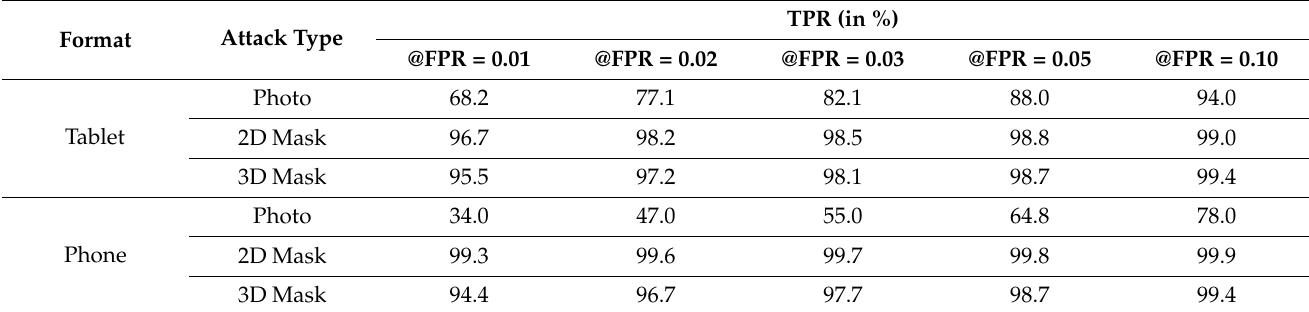
Table 5. TPR at various FPR settings (trajectory: composite, duration: 3 + 3 s).